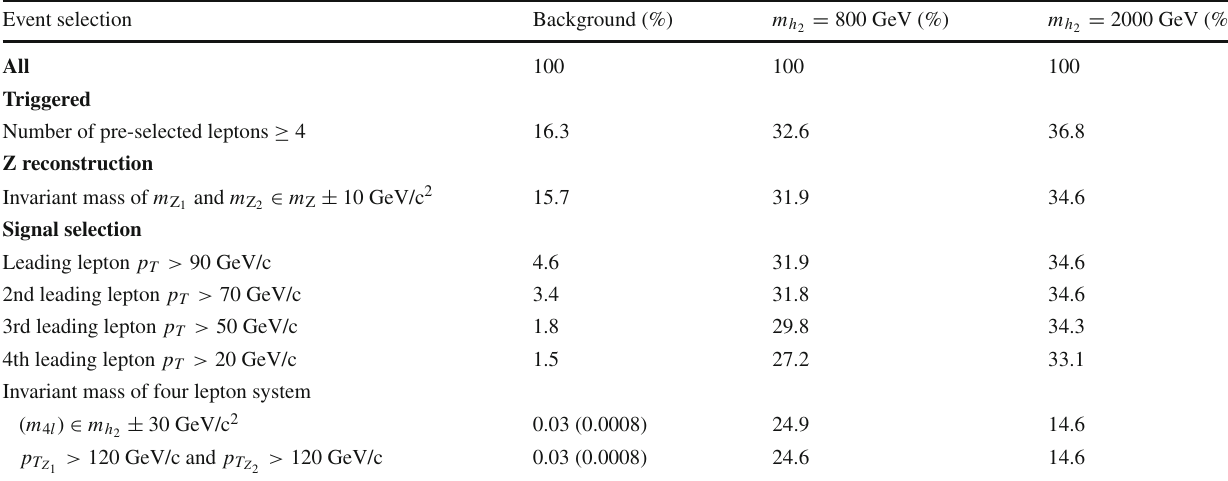
Table 3 Effects of various selection cuts for the analysis of signal and background events at 14 TeV. The values for the background are given for = 800 GeV by default while the values in parenthesis indicate the remaining percentage of events for m m h 2